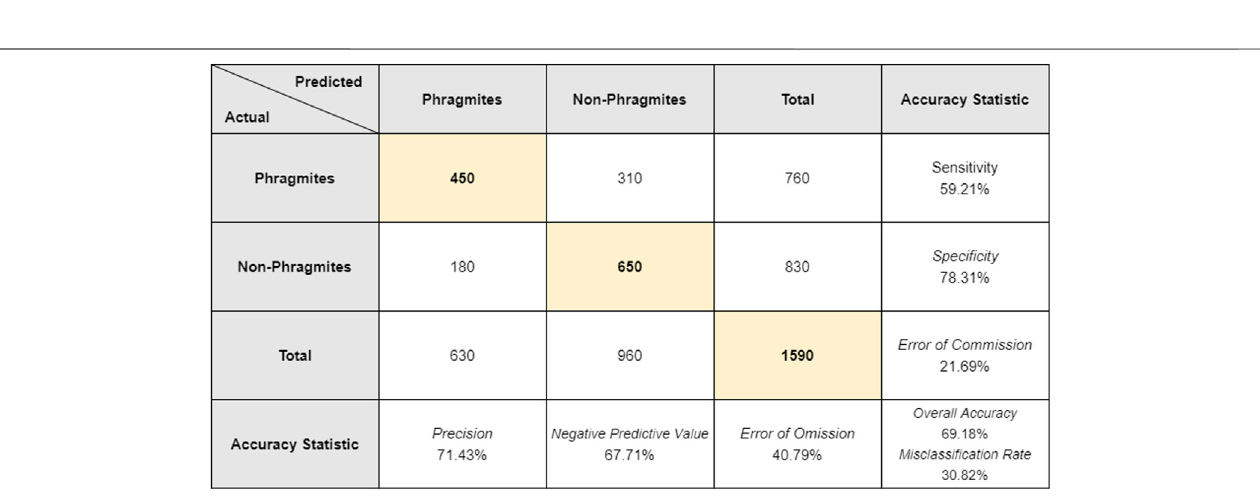
FIGURE12| Theactualandpredictedpointsasdeterminedbythe10visualinterpreters.Eachinterpreterexaminedthefullsetof159validationpoints,leadingtoa totalof1,590samples.Thehighlightedvaluesonthediagonalrepresentthenumberoftruepositivesandtruenegativesoutofthetotalsamplesize.Calculatedaccuracy statistics are shown in the last row and last